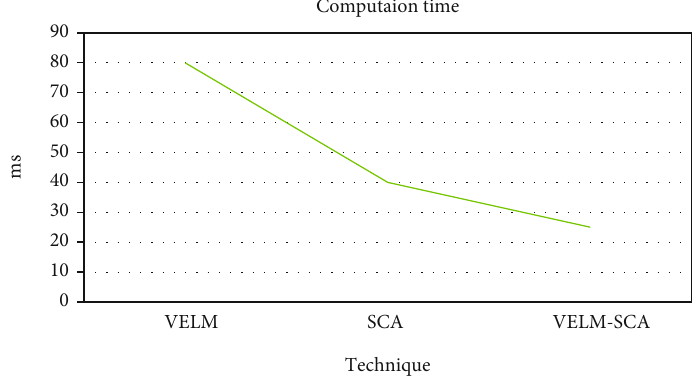
Figure 2: Computation time.